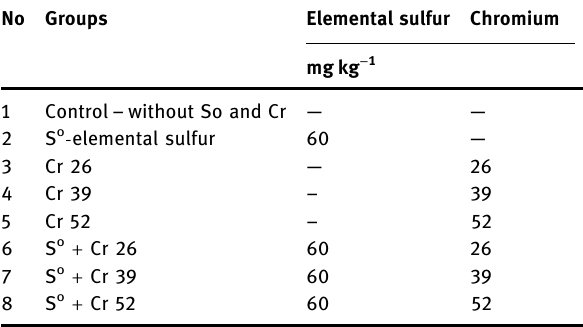
Table 2: Treatment in the pot